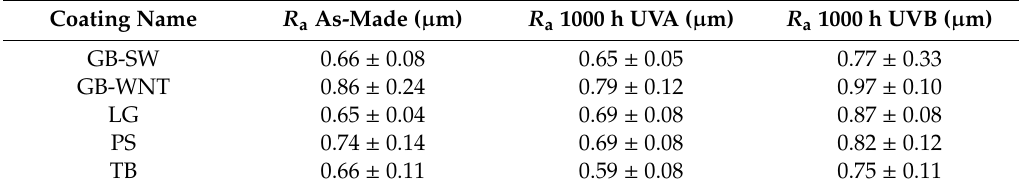
Table 3. Sample roughness before and after 1000 h irradiation with UVA and UVB light.